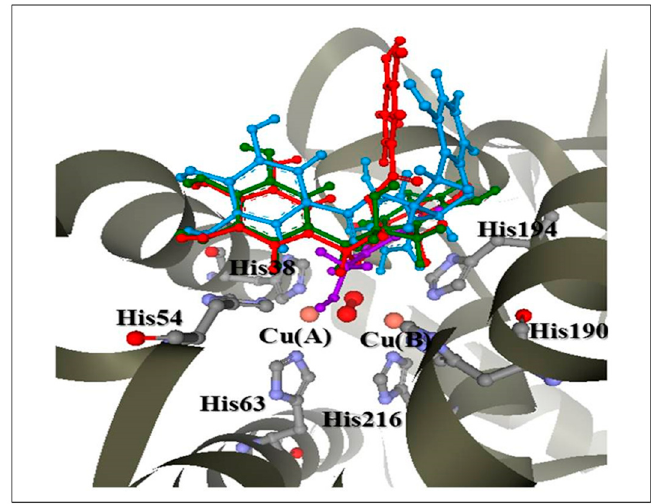
Figure 7. The docked conformations of the ligand structures in the tyrosinase-binding site. KA (Purple), ECG (Blue), EGC (Green), and EGCG (Red).